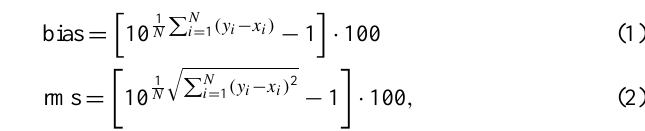
Figure 1. (a) Spatial distribution of the 4492 in situ stations used in the matchup analysis (see Sect. 3.1) along with the partition of the area of study. The Skagerrak and Kattegat is highlighted in blue with 1456 matchup points, Central Baltic is highlighted in red with 2922 matchup points, and the Gulf of Bothnia is green with 114 stations. Temporal station distribution is also shown using the same colour code (b) . The frequency distribution of the entire in situ Chl a is shown in panel (c)